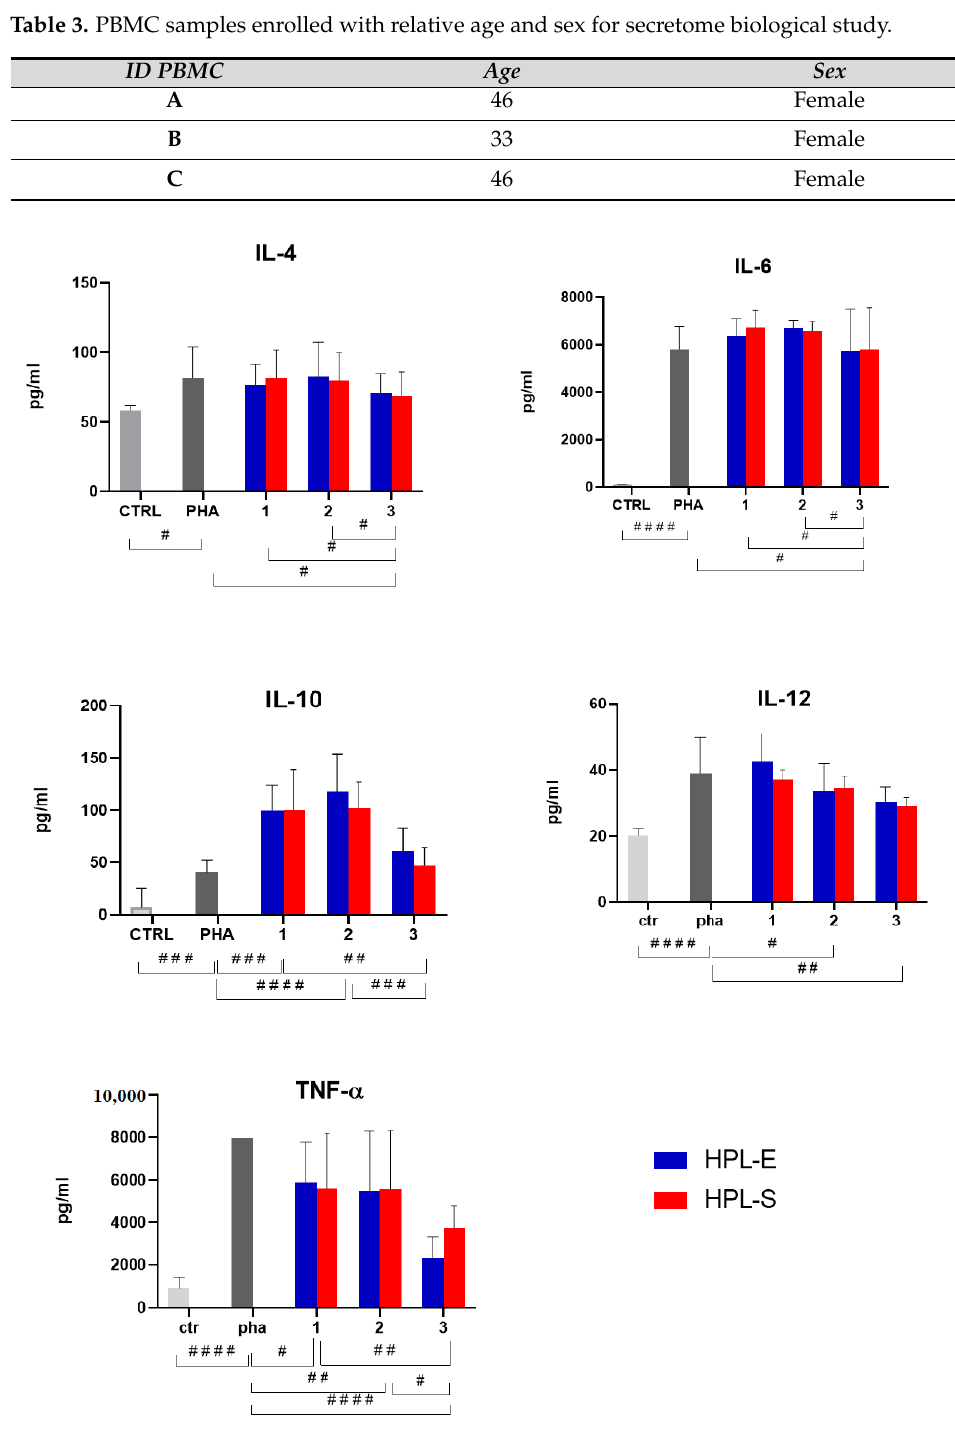
Figure 6. Modulation of cytokine production from PHA-activated PBMCs after treatment with freeze-dried MSC-secretome obtained from cell lines 1, 2, and 3 and expanded with LyoS-HPL-E or LyoS-HPL-S. Multifactor ANOVA, mean values ± LSD, n = 3 are reported. The symbols #, ##, ### and #### indicate a significant difference between the means of the different batches (respectively, p < 0.05, p < 0.01, p < 0.005 and p < 0.0001). No significant differences are reported between 2 HPLs in all cytokine analyses.